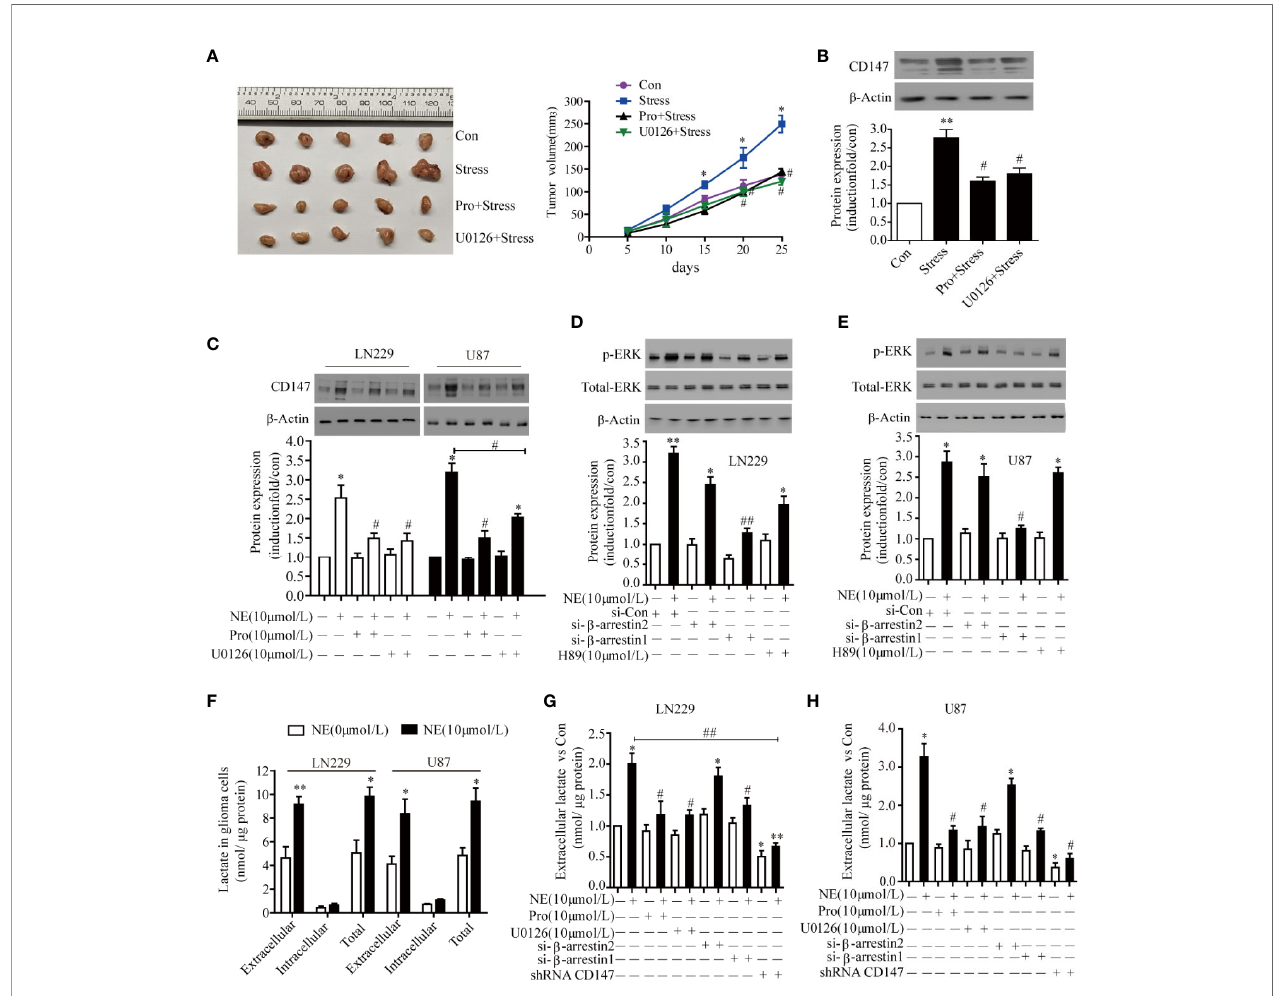
FIGURE 4 | The b -adrenergic Receptors/ b -arrestin1/ERK Signaling Pathway Regulated CD147 Expression. (A) Propranolol and U0126 reduced tumor size in vivo . (B) U0126 and Propranolol blocked the expression of CD147 induced by stress. (C) U0126 and Propranolol blocked norepinephrine (NE)-induced CD147 expression. (D) ERK1/2 signaling regulated CD147 expression in LN229 and (E) U87 cells downstream of b -AR. Cells were treated with NE (10 m mol/L) for 16 h. The effect of U0126 (10 m mol/L) on NE-induced CD147 expression was monitored by western blotting and quanti fi ed. (F) The production of lactic acid in extracellular and intracellular compartments of glioma cells under the effect of NE. The ERK1/2 inhibitor U0126 (10 m mol/L) inhibited NE-induced lactate release in LN229 cells (G) and U87 cells (H) , which was also inhibited by propranolol, shRNACD147, and si- b -arrestin1. Data are expressed as the mean ± SD. *P < 0.05. **P < 0.01 vs NE (0 m mol/L); # P < 0.05. ## P < 0.01 vs NE (10 m mol/L) or